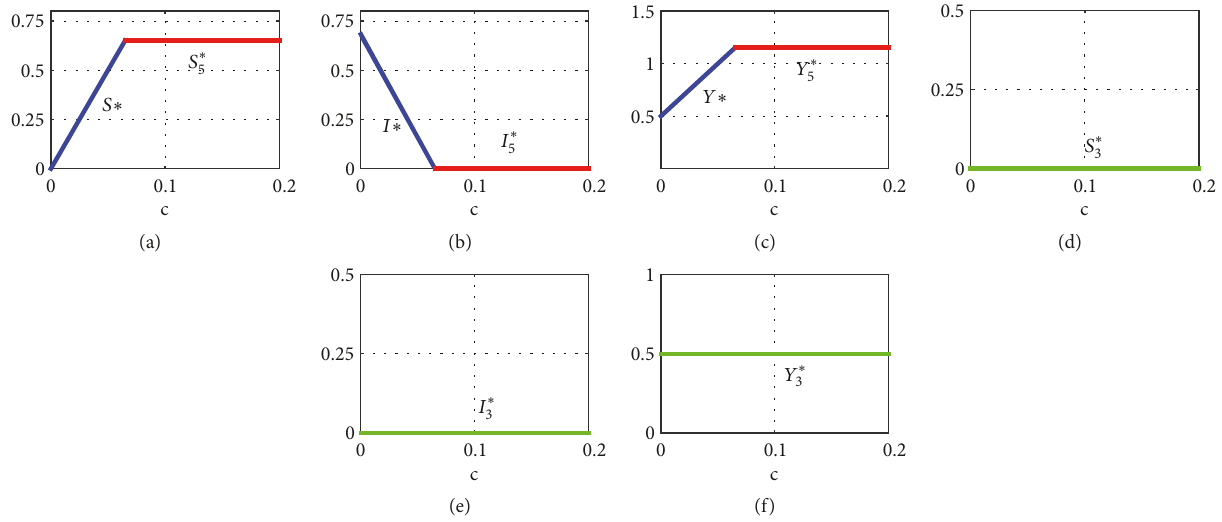
Figure 4: The stable equilibrium point as function of 𝑐 for ((a)-(c)) 𝛼 = 0 and ((d)-(f)) 𝛼 = 0.8 . The parameter values are 𝑟 = 1,𝐾 = 1,𝛽 = 0.1, 𝑎 = 0.25,𝑐 = 0.5,𝑐 = 0.25,𝑘 = 1 , and 𝑘 = 0.5 2 1 2 1 2